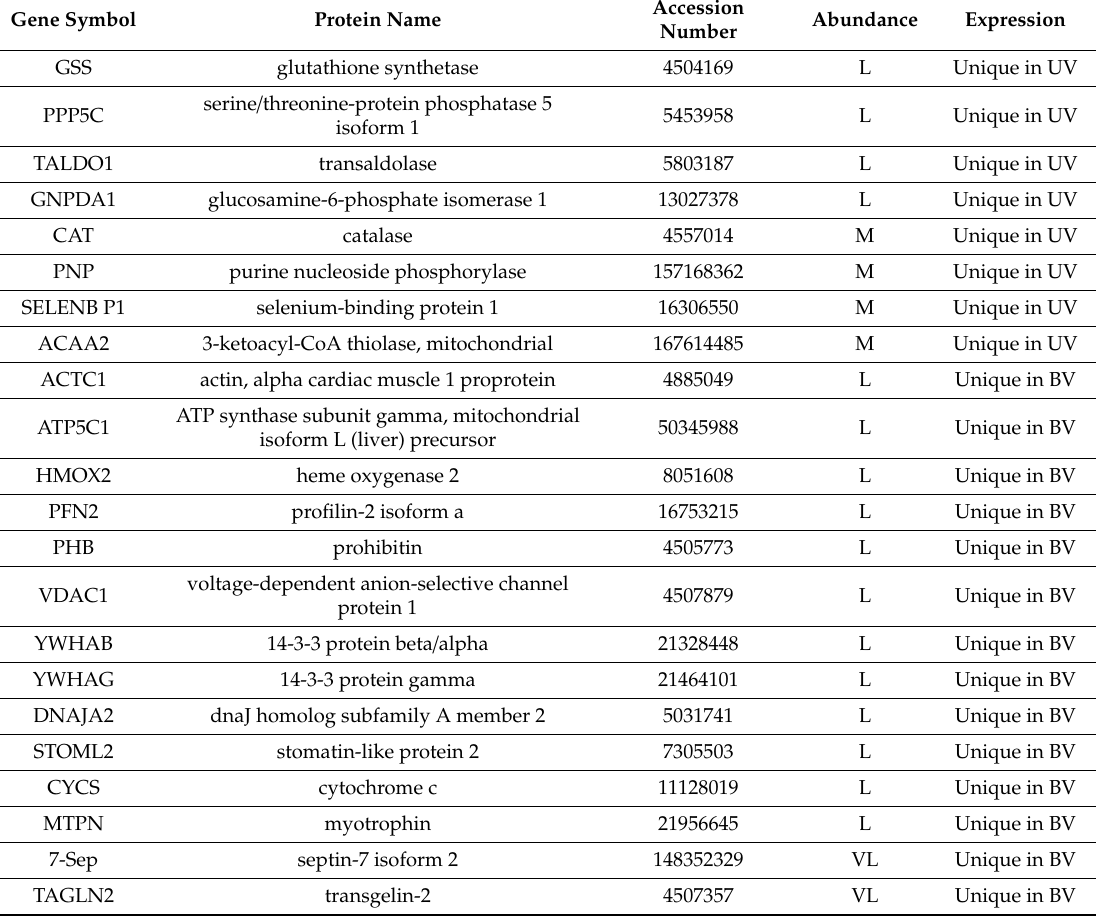
Table 3. Important proteins with enriched lysine acetylation uniquely expressed in the unilateral varicocele (UV) and bilateral varicocele (BV)